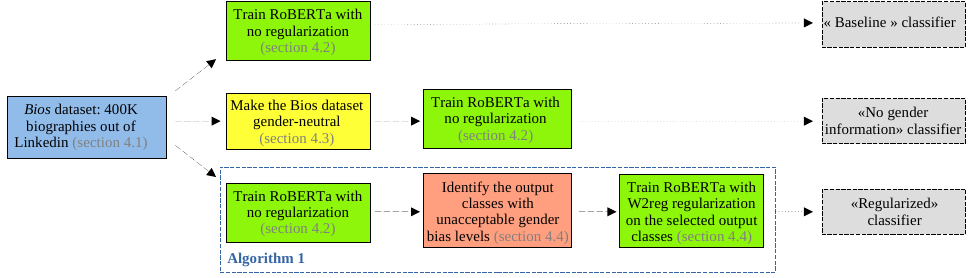
Figure 3. Pipelines followed to define the three classifiers compared in Section 5.